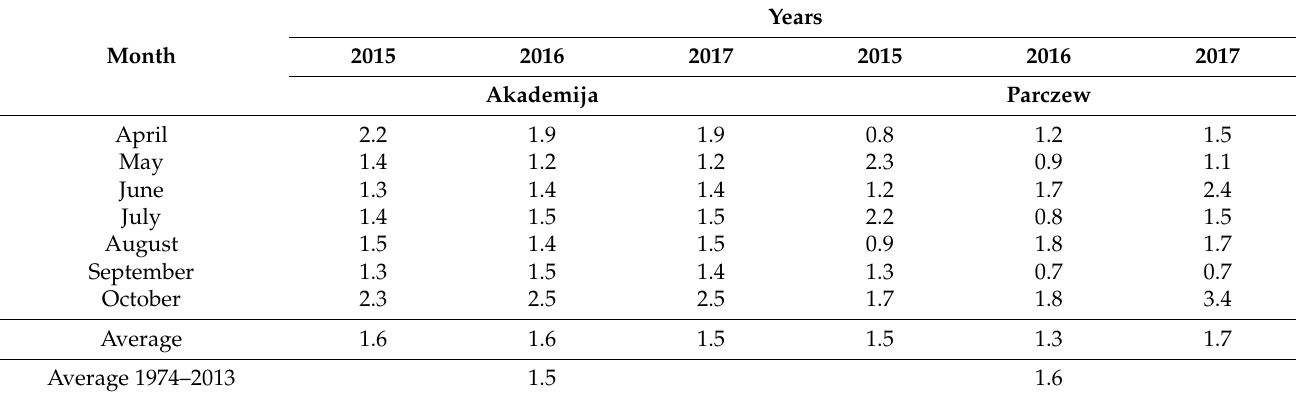
Table 3. The value of the Sielyaninov Hydrothermal Coefficient (SHC) for meteorological stations at Akademija and Parczew